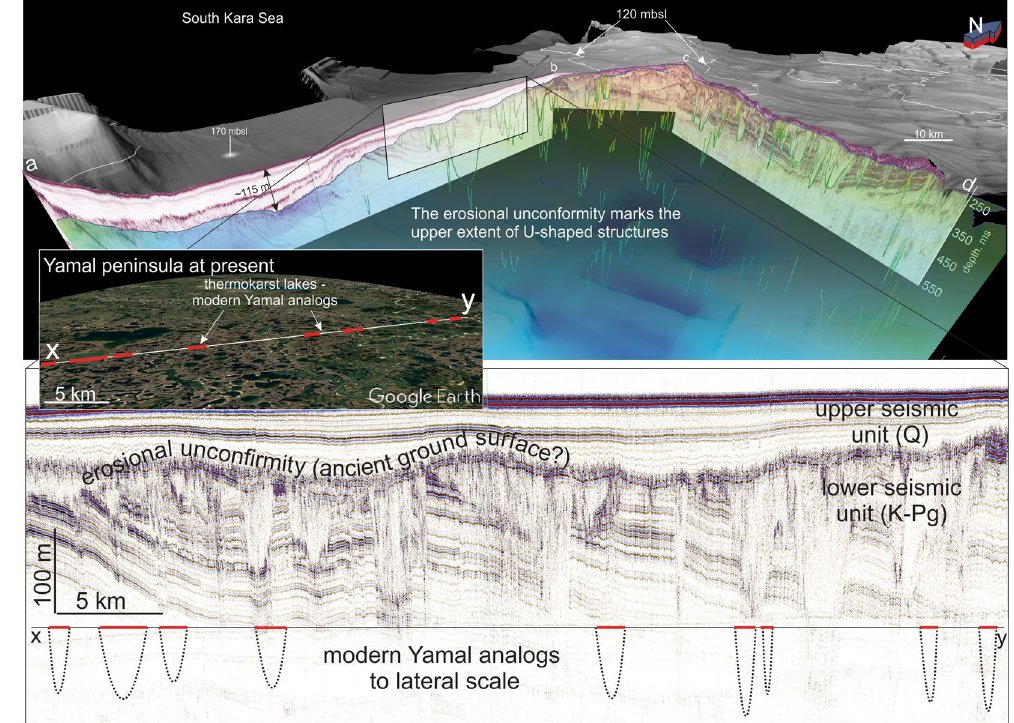
Figure 2. 3-D image of the upper sediment cover of the South Kara Sea (see location a-b-c-d in Fig. 1). Shaded gray surface shows high-resolution seismic-derived bathymetry; colored semi-transparent surface indicates unconformity between lower and upper seismic units on top of U-shaped structures (green curves) – remnants of ancient thermokarst. Insets demonstrate the spatial and dimensional similarities between U-shaped structures offshore (middle section) and modern thermokarst lakes onshore Yamal Peninsula (bottom section), which are shown at the same lateral scale. Note different vertical scales (ms and meters); conversion was based on 1600 m/s for acoustic velocity in silt. Satellite image source: “Yamal Peninsula”. 68°55 ′ 53 N and 69°24 ′ 21 E, eye altitude 12 000 m. Google Earth. December, 2016.